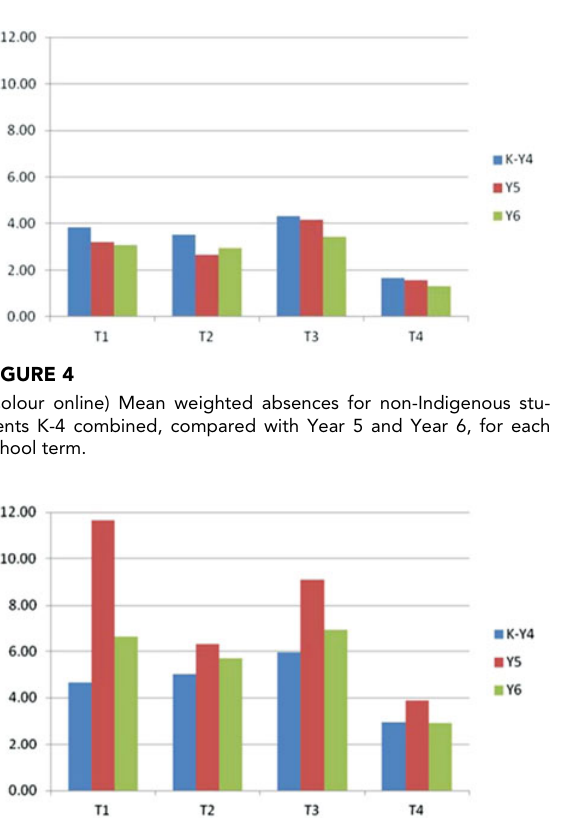
(Colour online) Mean weighted student absences for Indigenous stu- dents K-4 combined, compared with Year 5 and Year 6, for each school